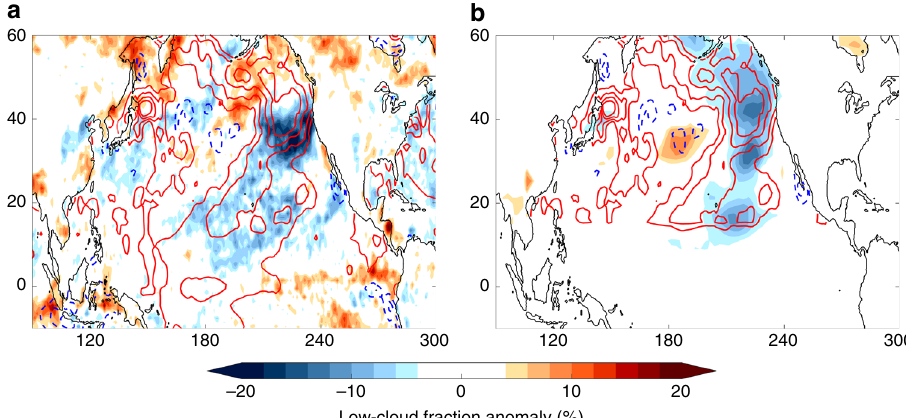
Fig. 6 Low-cloud fraction anomalies for June – August 2019. Low-cloud fraction anomalies (shading; %) from a satellite-derived observations and b ensemble mean of North Paci fi c sea surface temperature forced experiment. Colored contours represent observed sea surface temperature anomalies (SSTAs; °C) seen by both ( a ) and ( b ), respectively. SSTA contour interval is 0.5 °C with a maximum value of 2 °C. Simulated anomalies shown are signi fi cant at 95% for a Student ’ s t